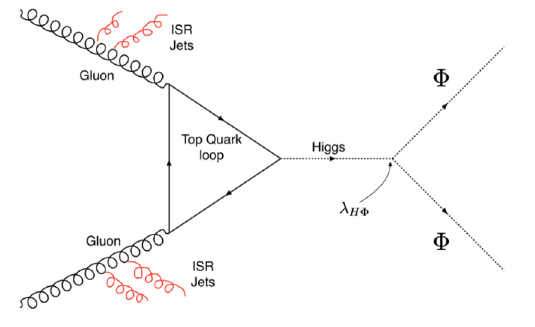
Figure 14 . /E + jets signature that the model can produce at the T